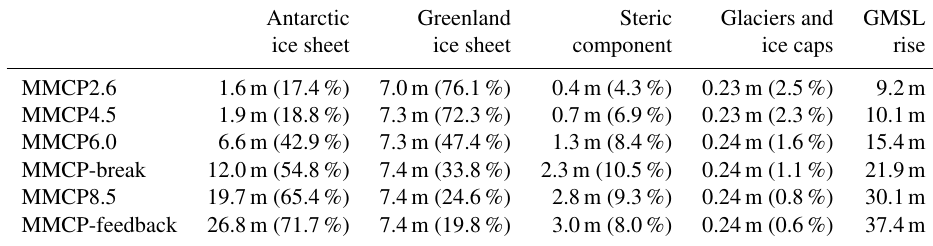
Table 1. Sea-level contribution from the different components contributing to GMSL change for scenarios MMCP2.6, MMCP4.5, MMCP6.0, MMCP-break, MMCP8.5, and MMCP-feedback, shown in metres and as a percentage of GMSL change. Antarctic